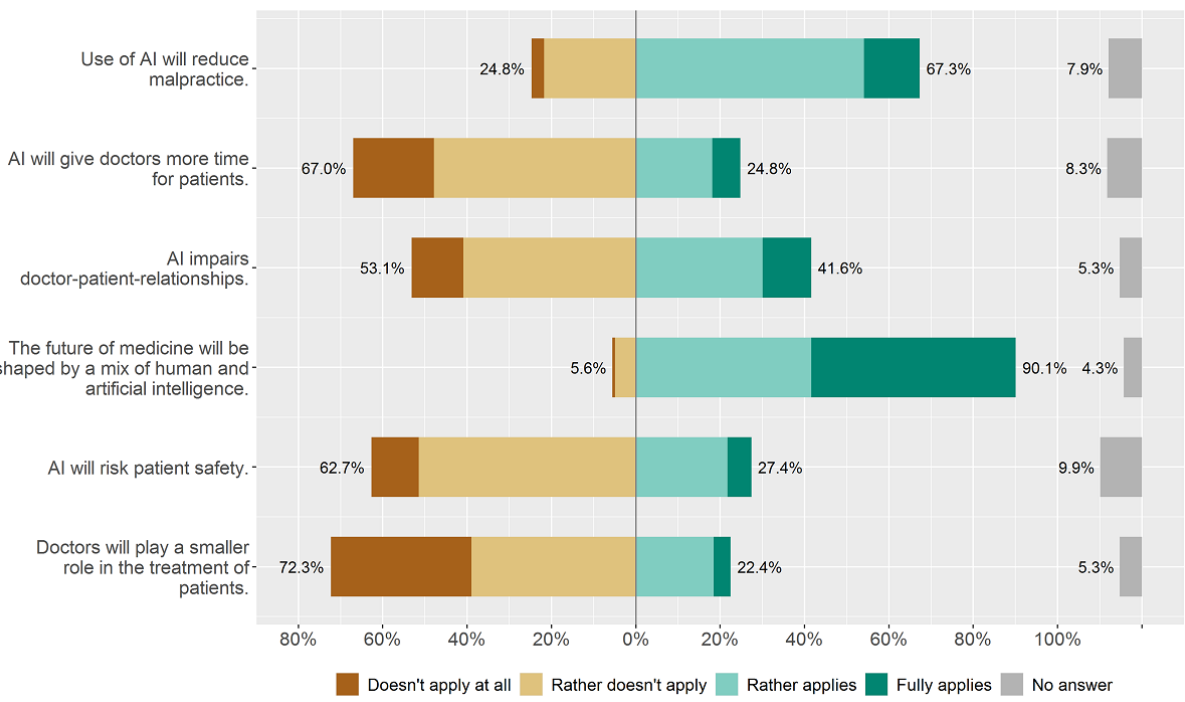
Figure 2. Effect of artificial intelligence (AI) on medical treatment.